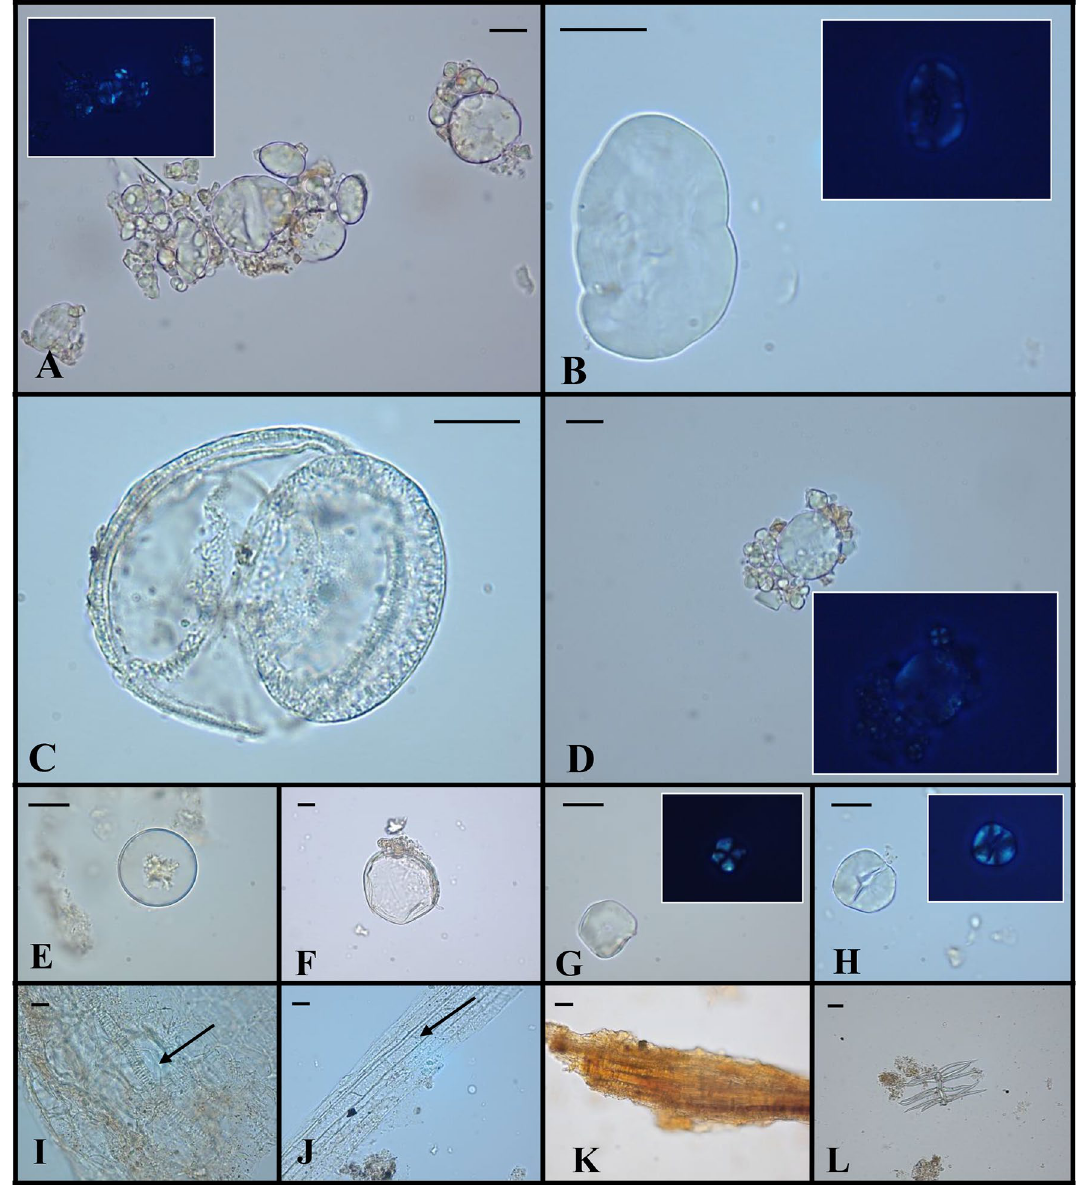
( A ); Fabaceae starch granule and relative polarized image ( B ); Pinaceae pollen grain ( C ); aggregate of Triticeae starch granules and relative polarized image ( D ); Cupressaceae pollen grain ( E ); Poaceae spontaneous group pollen ( F ); polyhedral starches of morphotype II ( G , H ); fragments of plant tissues ( I – K ); dendritic hair ( L ). The scale bar indicates 15 µm [45 µm for panel ( L )]. Small flecks of calculus still attached to microremains can be observed in some